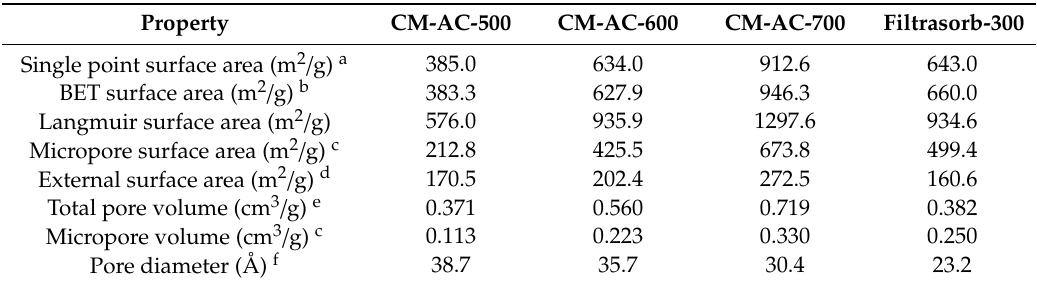
Table 1. Pore properties of resulting activated carbons (ACs), cow manure-derived activated carbon (CM-AC) and commercial AC